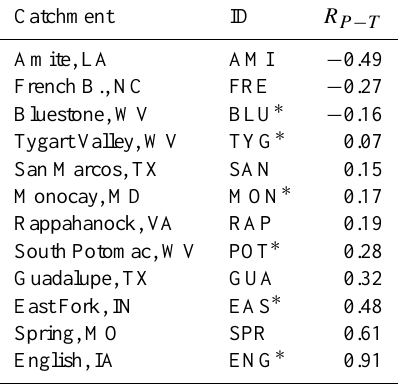
Table 2. Linear correlation coefficient between mean monthly precipitation and mean monthly temperature ( R P − T ) for the 12 MOPEX catchments.